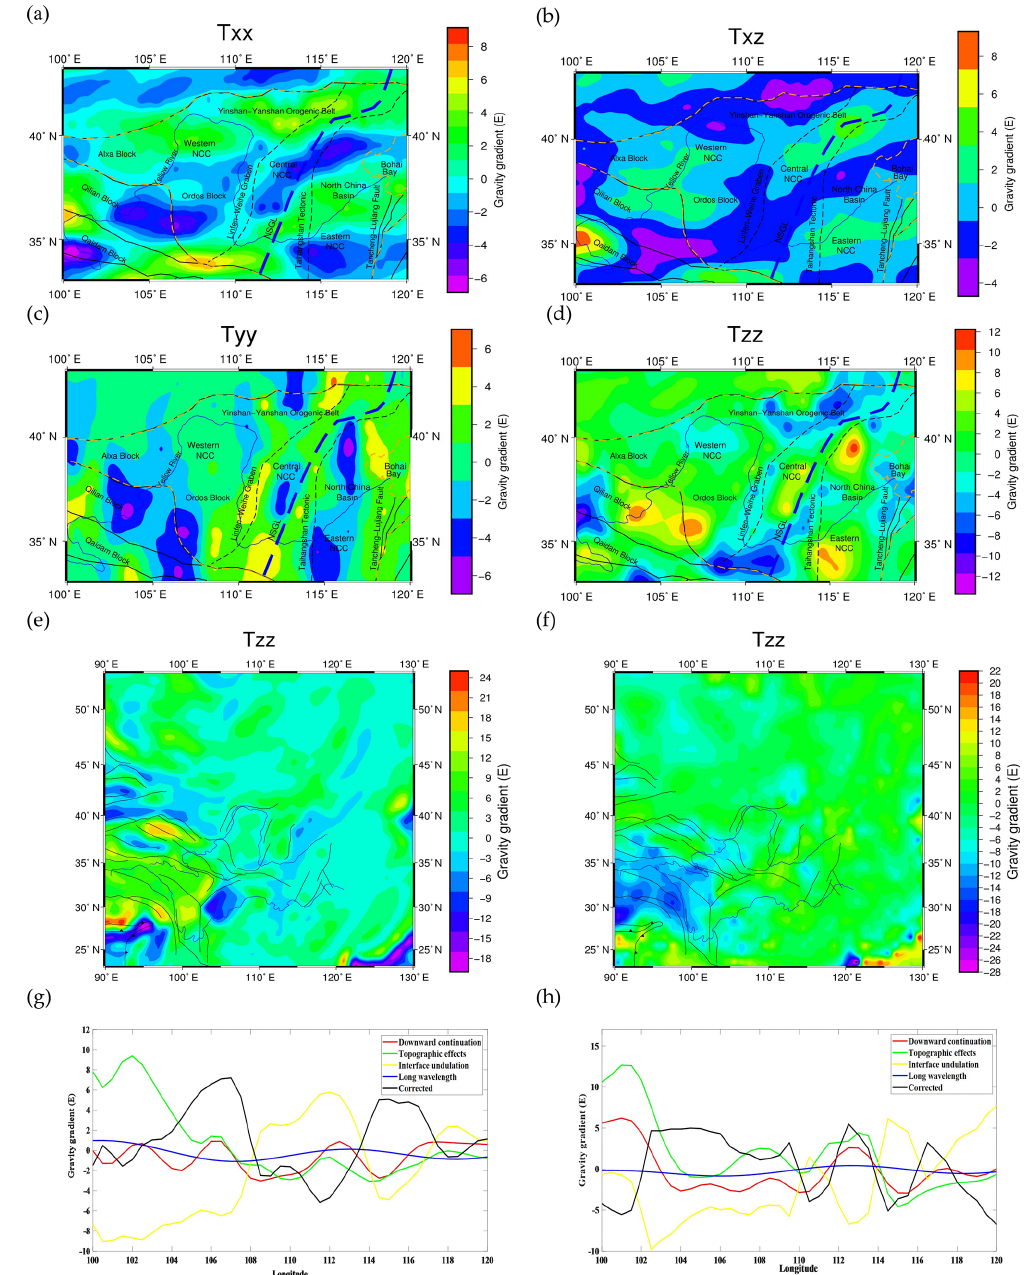
Figure 13. The corrected gravity gradient components (a) T xx , (b) T xz , (c) T yy and (d) T zz are shown. Gravity gradient effects with extended area topographic effects T zz (e) and interface undulation T zz (sedimentary and Moho) effects (f) are shown. Several corrections, T zz , at different cross sections are given: (g) latitude 35 ◦ and (h) latitude 37.5 ◦